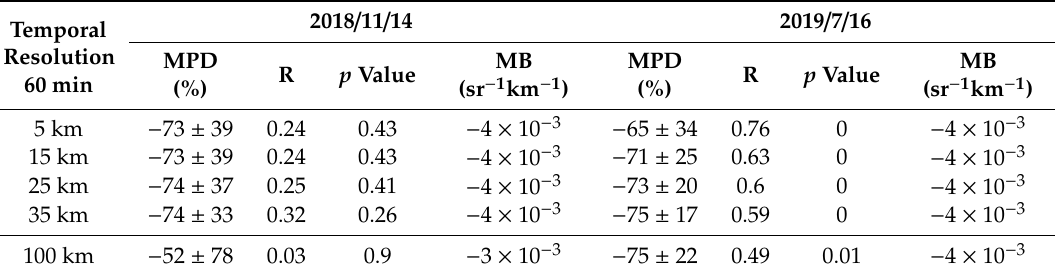
Table A5. Statistical results (Mean Bias (B), Correlation Coe ffi cient (R) and p value) derived from simultaneous measurements between CALIOP and Mace Head data for a cloud–free case (18 / 11 / 14) and for a case with a thin cloud (19 / 07 / 16) considering di ff erent along–track averages in CALIOP data (5 km, 15 km, 25 km, 35 km, and 100 km) and 60 min temporal resolution in Mace Head